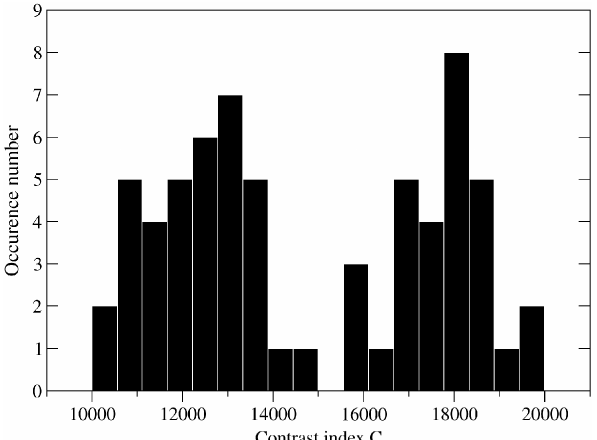
Fig. 5. Histogram of the contrast index (C), which depends on the texture of surface pictures, for the 2009–2010 summer